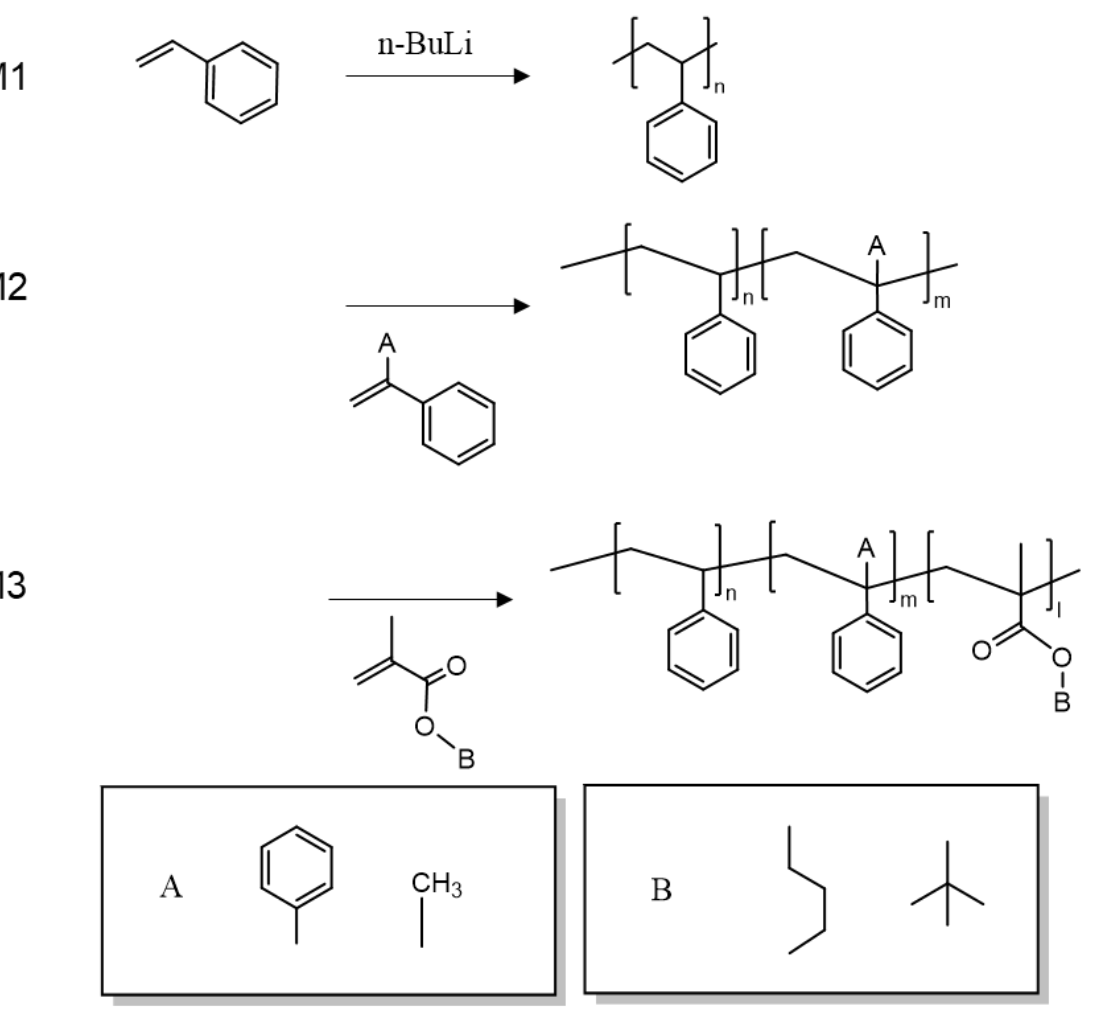
Figure 1. Synthesis scheme of amphiphilic block copolymers.